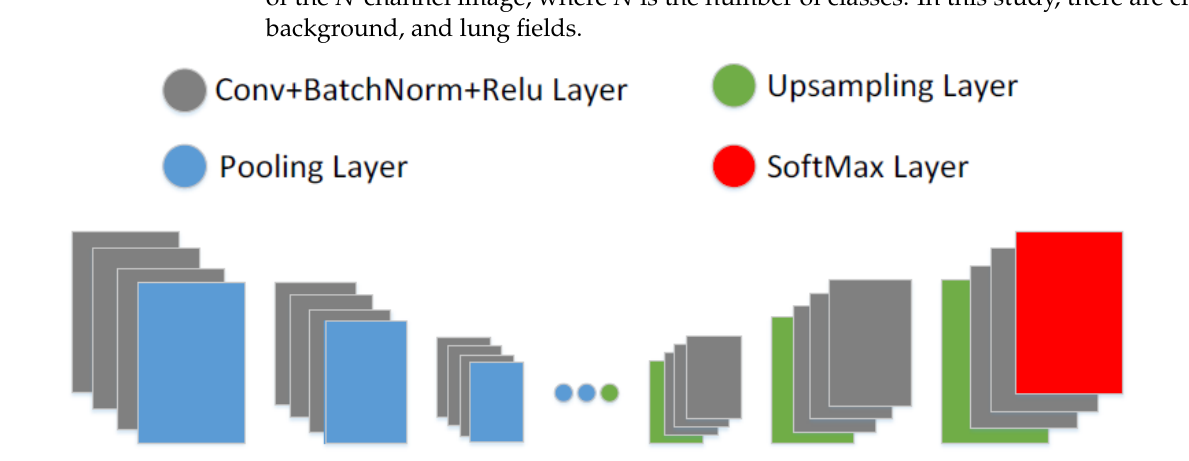
Figure 7. The architecture of the encoder–decoder segmentation network.